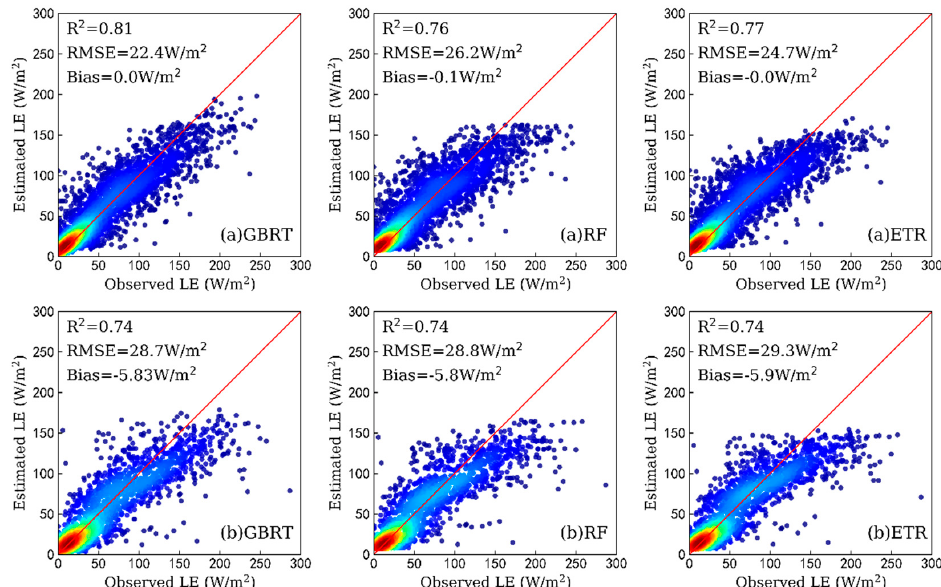
Figure 3. The performance indices result of the training and testing data from the first cross-validation experiment (the last year of all sites were tested, and the others were trained) for the three machine-learning algorithms. ( a ): training results; ( b ): testing results.